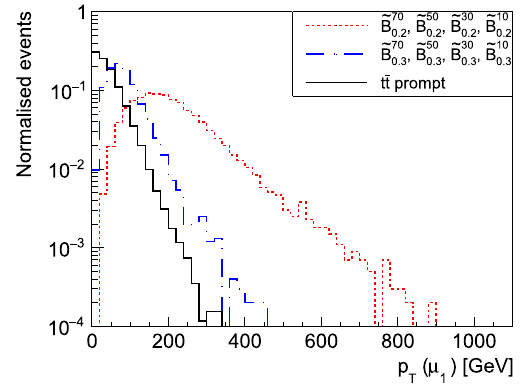
Fig. 12 Track multiplicity associated with displaced vertices in the ˜ B -like case